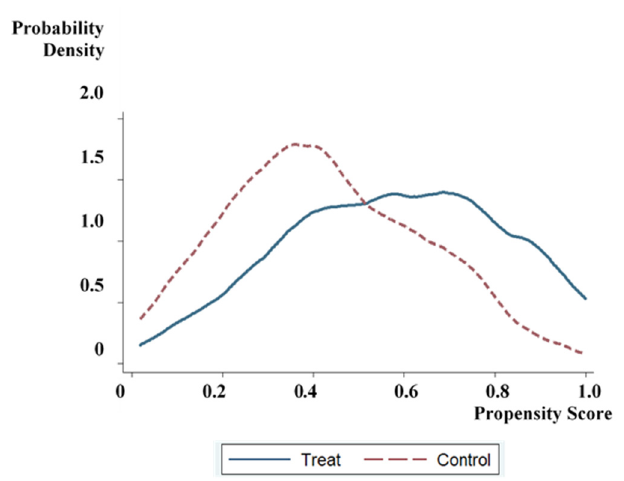
Figure 2. Density function graph before propensity score matching.